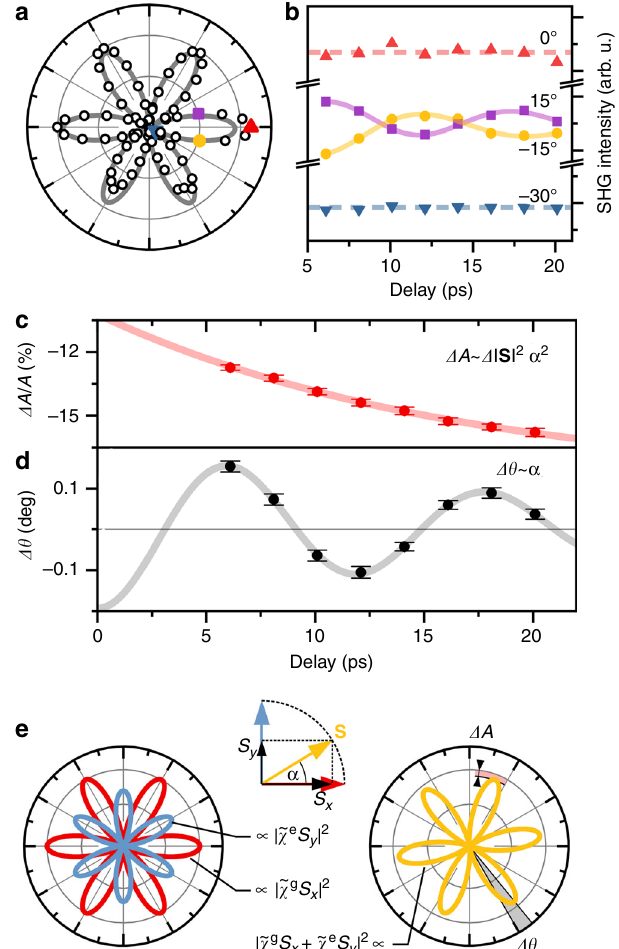
Fig. 3 TR modulation of the SHG anisotropy. a Measured ground state SHG anisotropy. b Time-dependent normalised correlated SHG intensity at different points of the anisotropy (see “ Methods ” ). c Time dependence of the relative amplitude change. d Time dependent rotation angle of the SHG anisotropy after excitation. Solid lines are fi ts. The error bars denote standard errors of the means determined from 16 consecutive measurements. e Red and blue curves are calculated SHG anisotropies cm ′ ( S k ^ x ) and P 6 ′ c ′ m ( S k ^ y ) symmetry, respectively. A according to P 6 ′ 3 3 spin canted by an angle α leads to a superposition of S x - and S y -related SHG contributions. Their interference causes a rotation and amplitude change of the SHG anisotropy (yellow curve)